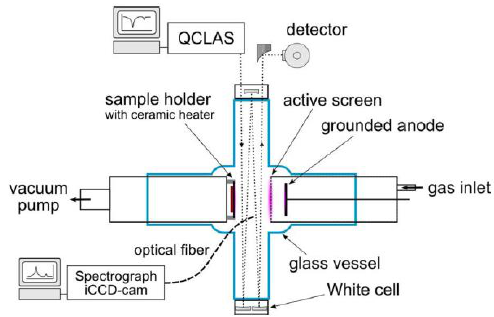
Figure 29. Experimental arrangement of the PLANIMOR model reactor combined with QCLAS and OES spectrometers. The plane of the White cell is parallel to the screen and the sample holder (it is rotated by 90° for better illustration) [63], Reproduced from [63], with the permission of AIP Publishing.